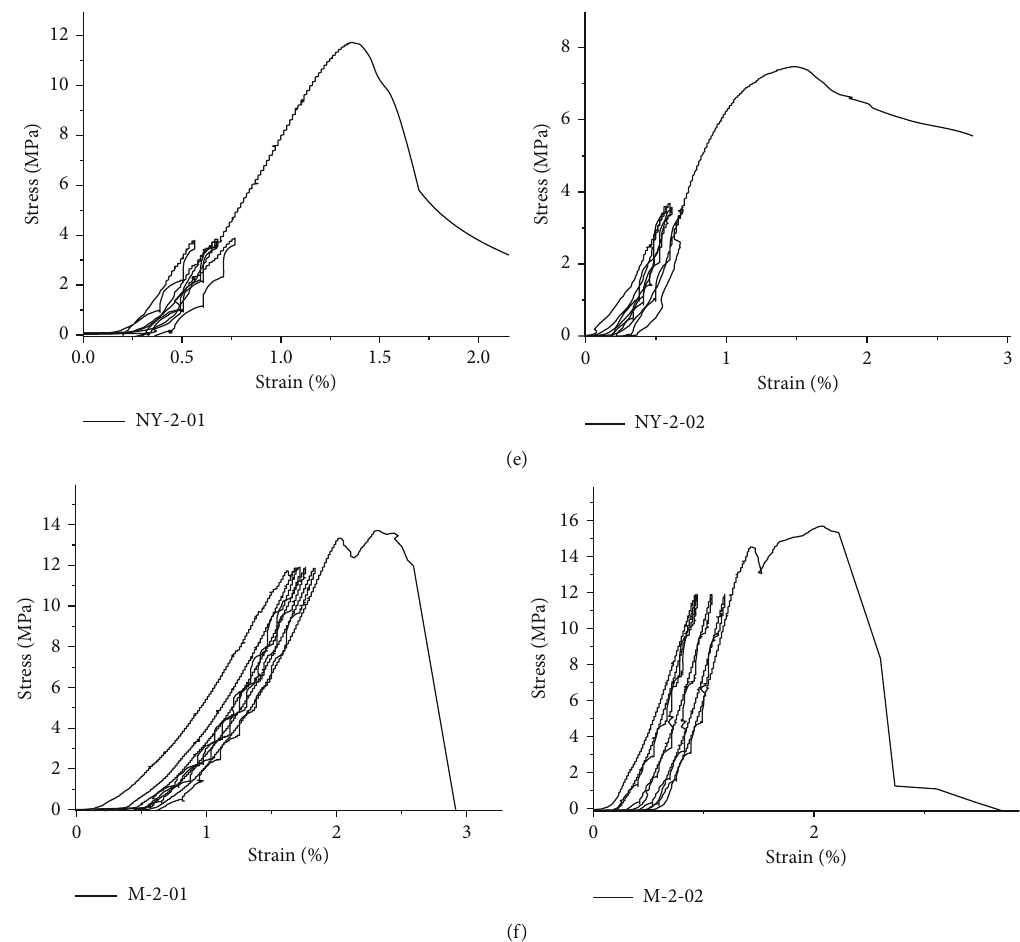
Figure 5: Total stress-strain curves. (a) Uniaxial compression for the SY lithology. (b) Uniaxial compression for the NY lithology. (c) Uniaxial compression for the M lithology. (d) Cyclic loading for the SY lithology. (e) Cyclic loading for the NY lithology. (f) Cyclic loading for the M